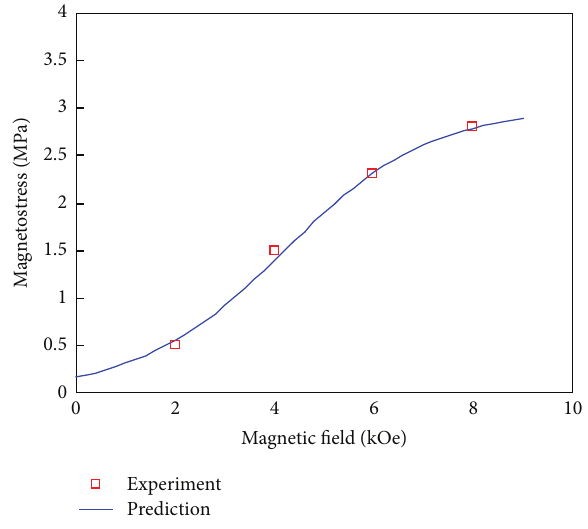
Figure 5: Magnetostress in average critical stress when different magnetic field is applied.